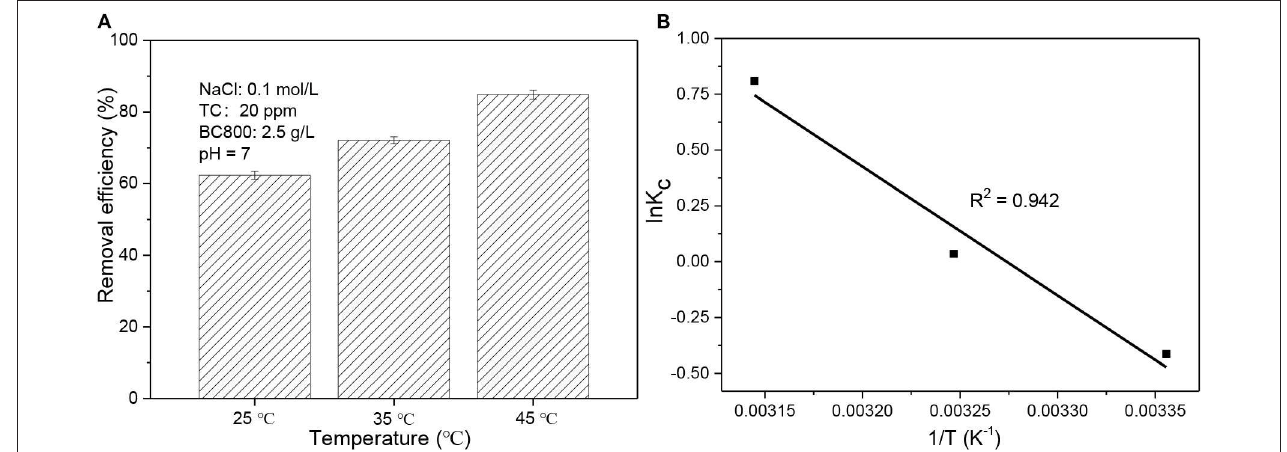
FIGURE 5 | (A) Adsorption performance of BC800 on TC solution at 25, 35, and 45 ◦ C; (B) 1/T vs. lnK C plot. BC800 stands for biochar prepared at 800 ◦ C.